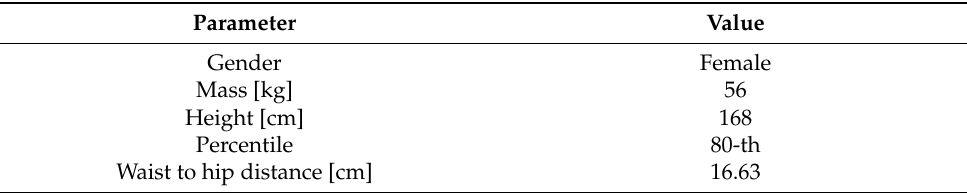
Table 1. The subject